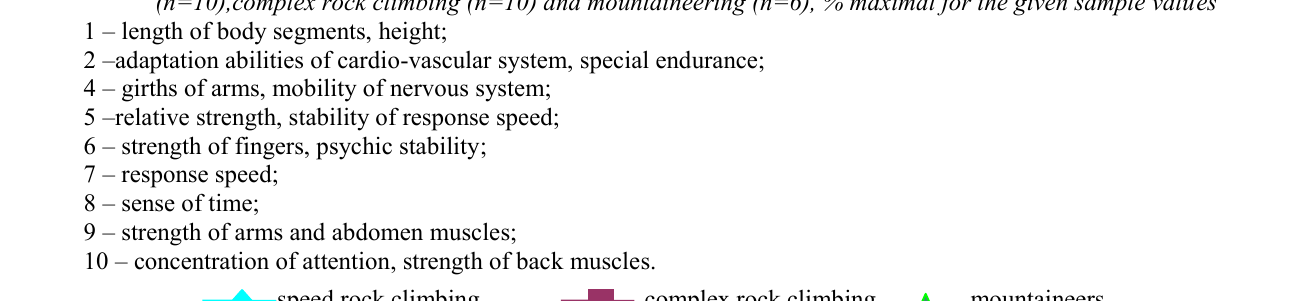
Fig. 2. Expressiveness of factors of complex elite sportsmen’s preparedness, who specialize in speed rock climbing (n=10),complex rock climbing (n=10) and mountaineering (n=6), % maximal for the given sample